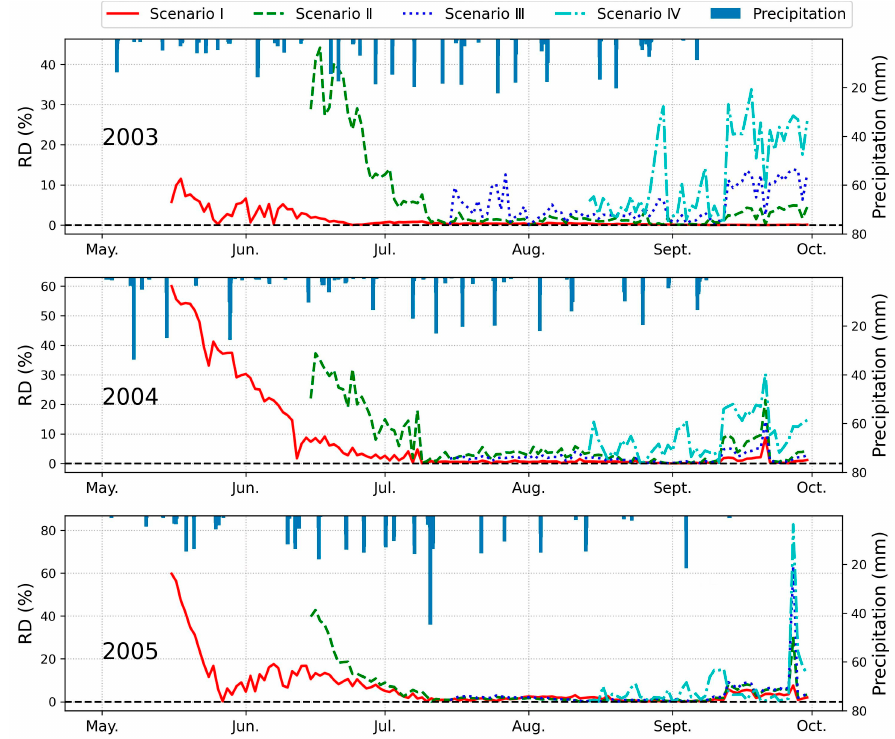
Figure 7. Same as Figure 6, but for latent heat flux prediction in four scenarios over 2003–2005.